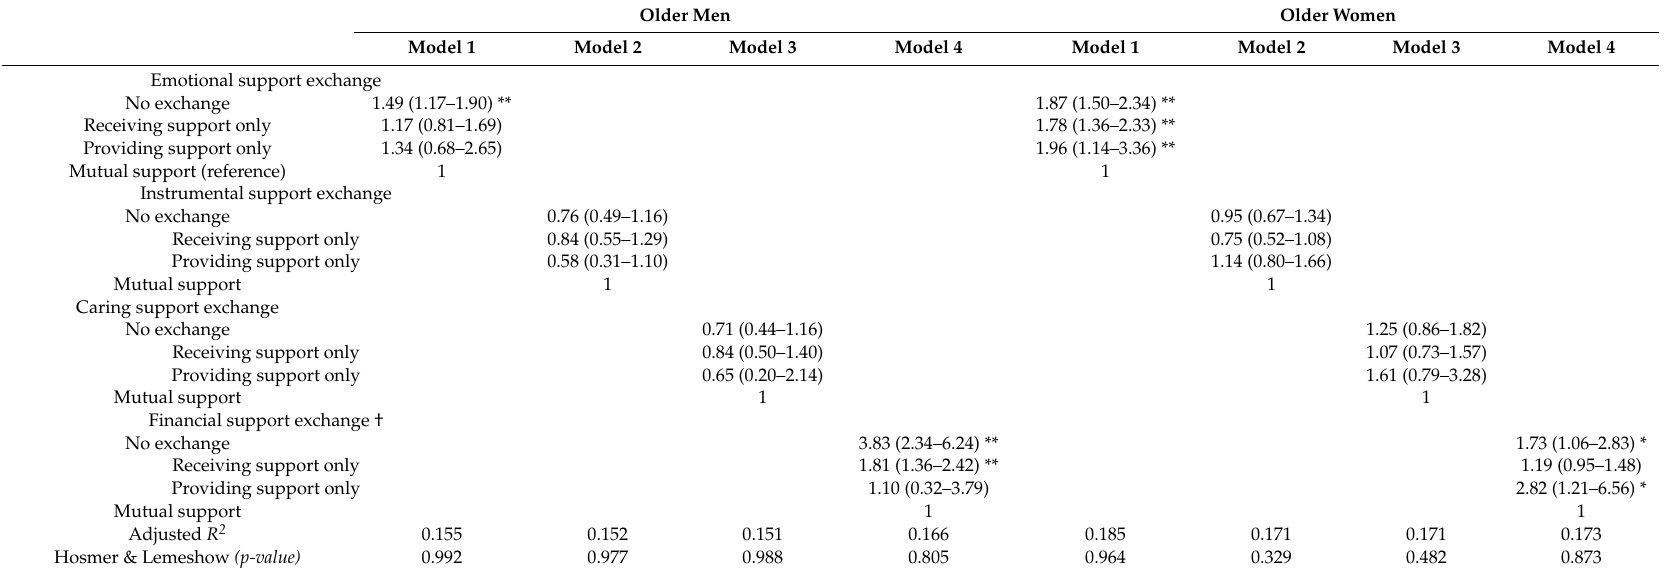
Table 2. Adjusted odds ratios (ORs) and 95% confidence intervals (CIs) for depressive symptoms among older men ( n = 3592) and older women ( n = 3939) in the 2017 Korean Living Profile Survey of Older